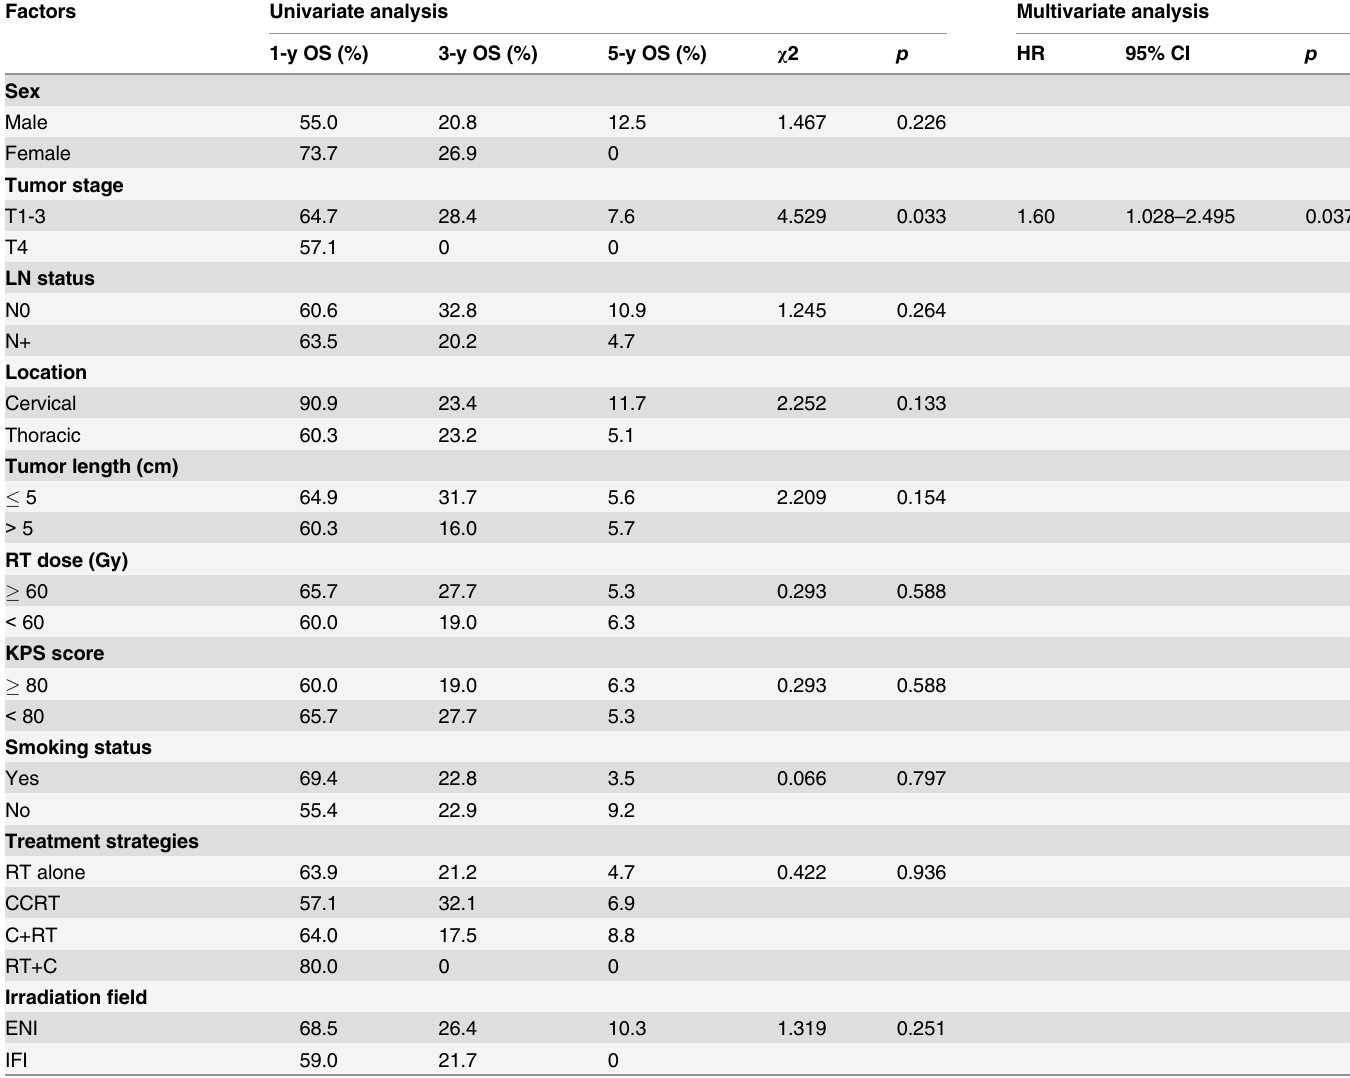
Table 2. Univariate and multivariate analysis of the effect of prognostic factors on OS in patients with esophageal cancer. Factors Univariate analysis Multivariate